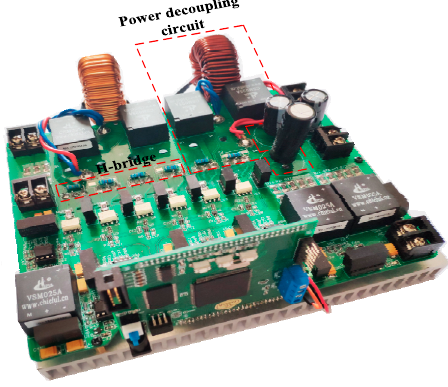
Figure 8. Picture of the experiment prototype.